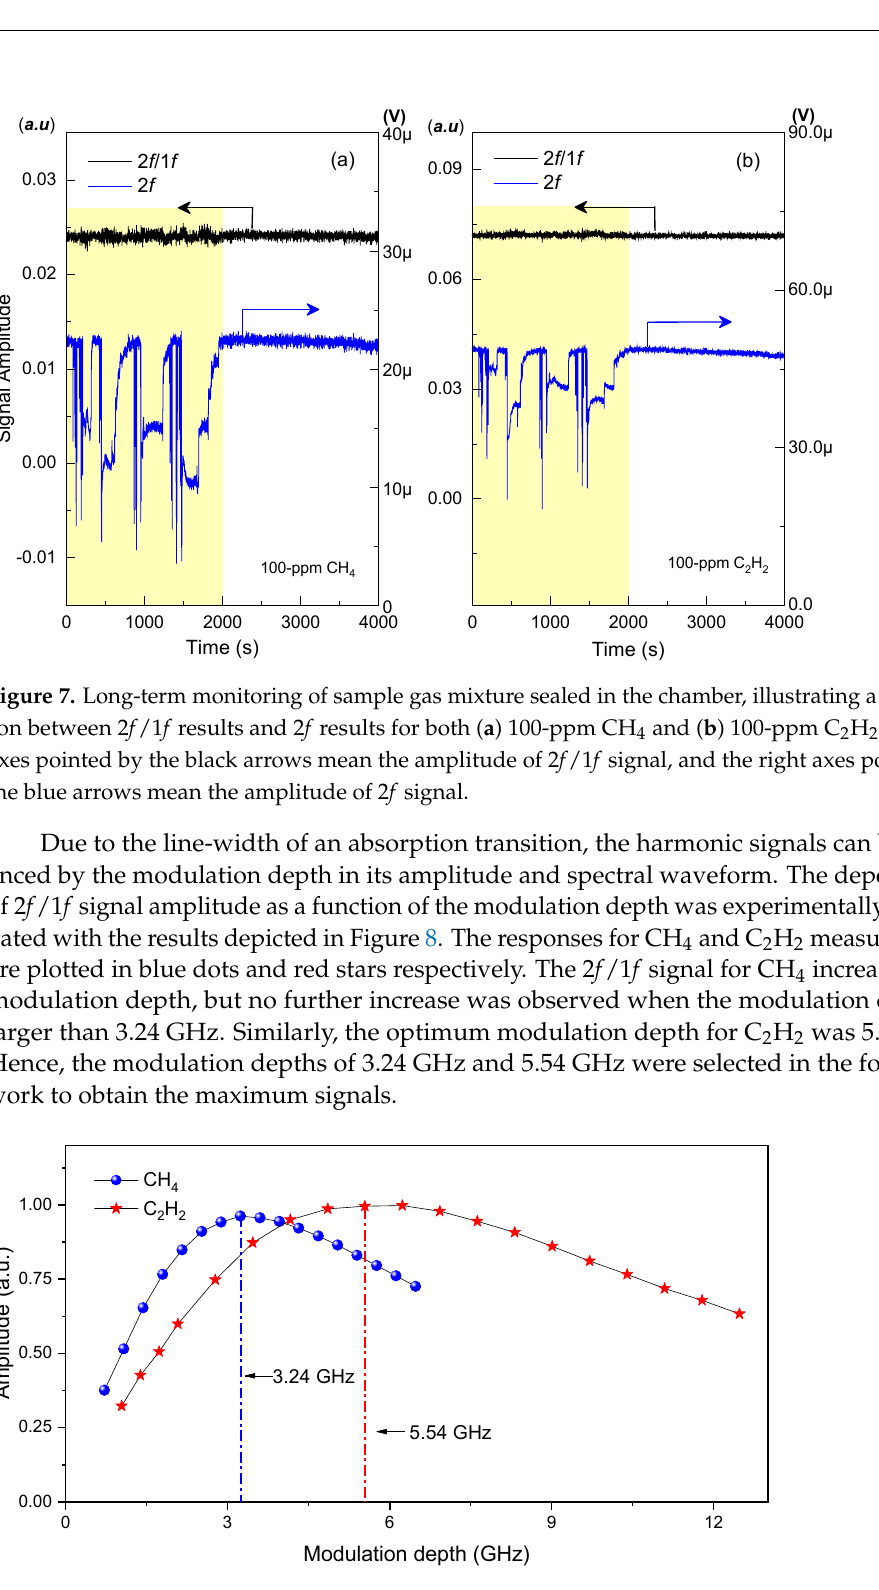
Figure 8. Normalized signal amplitude as a function of modulation depth.